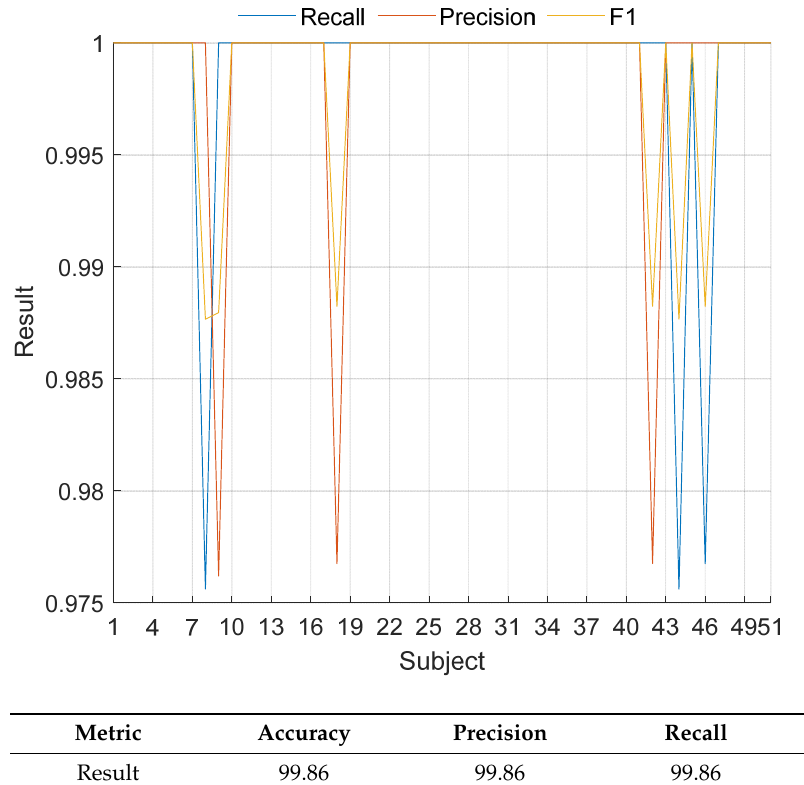
Figure 4. Subject-wise results of the proposed LBP-NCA-based coronary angiography print